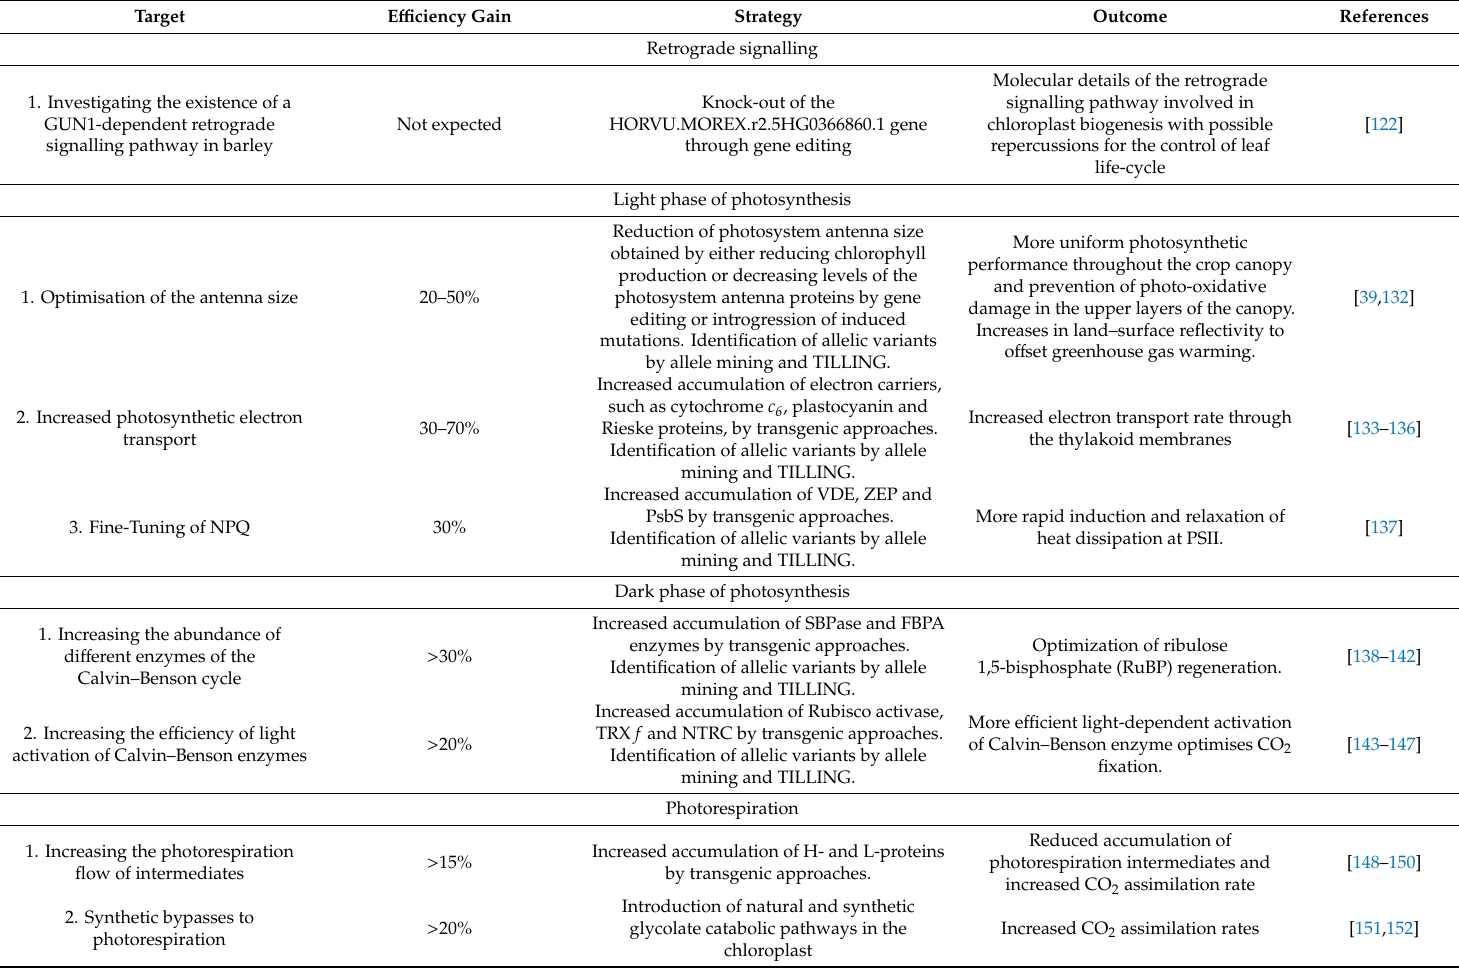
Table 4. Brief summary of biotechnological strategies that are being employed for photosynthesis improvement in